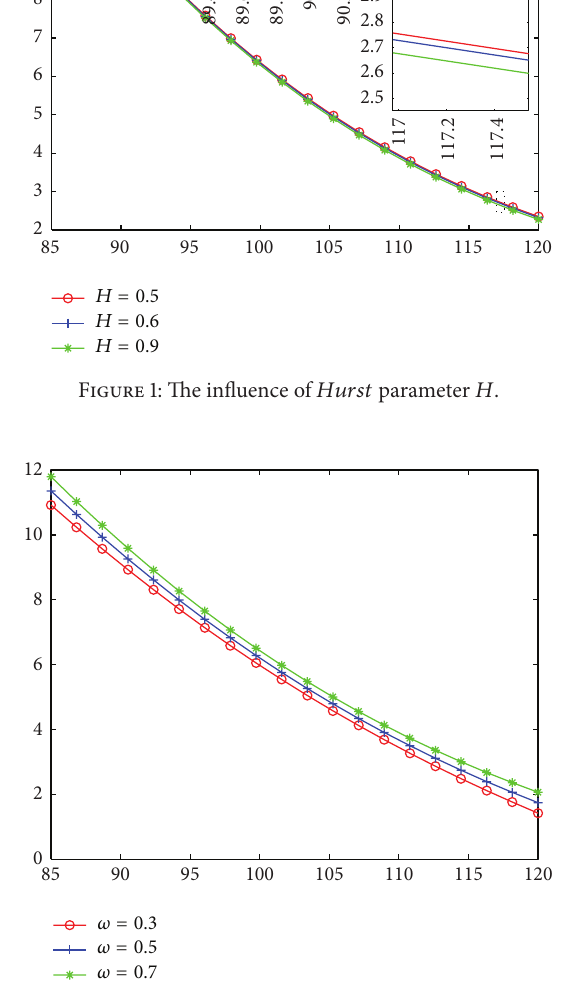
Figure 2: The influence of recovery rate 𝜔